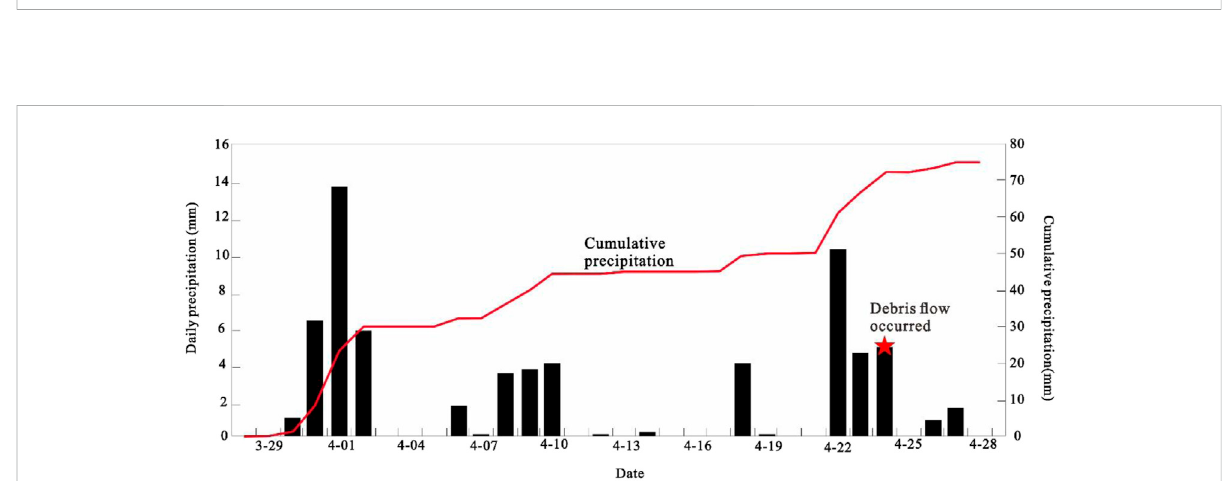
FIGURE 4 Precipitation variations in Ningxia County from 29 March 2021, to 29 April